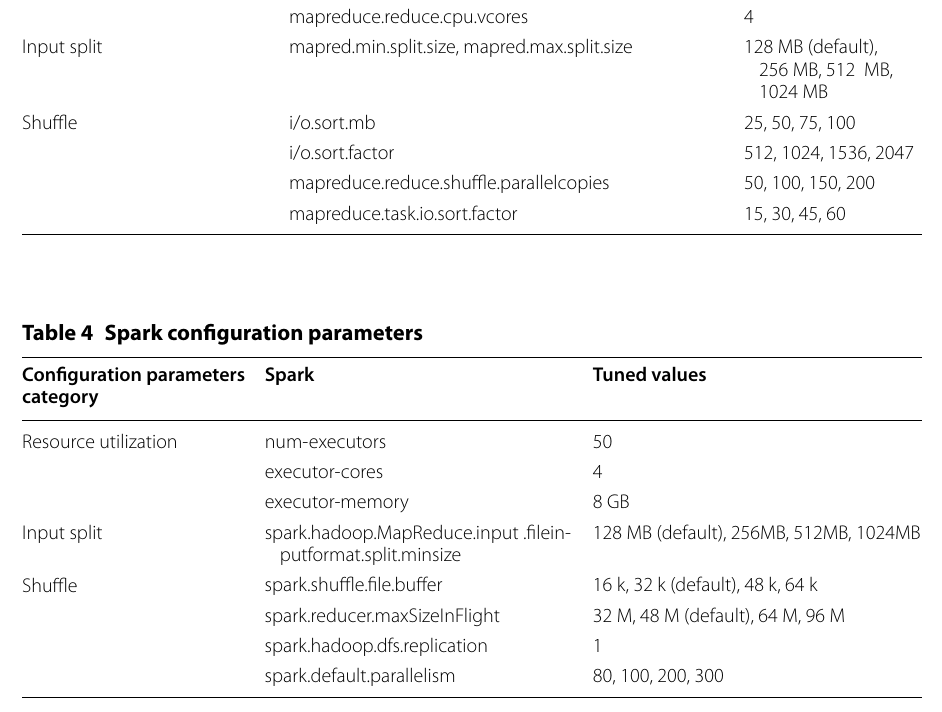
Table 3 Hadoop configuration parameters Configuration parameters Hadoop Tuned values category Resource utilization